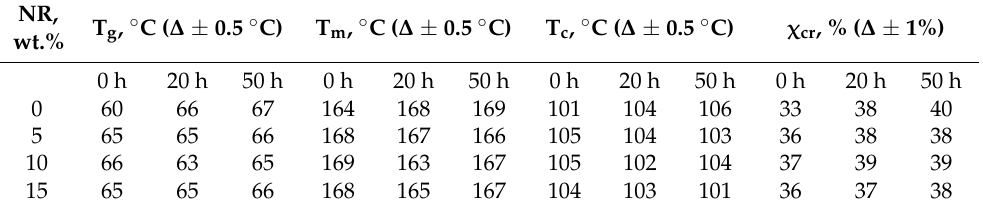
Figure 6. Thermograms of PLA/NR agrofiber samples from various compositions: initially and after UV radiation; λ = 365 nm for 20 and 50 h. The DSC method. Table 3. Thermophysical characteristics of PLA/NR nonwoven fiber samples: before and after 20 and 50 h of UV ‐ irradia ‐ tion exposure ( λ = 365 nm). NR, wt.%